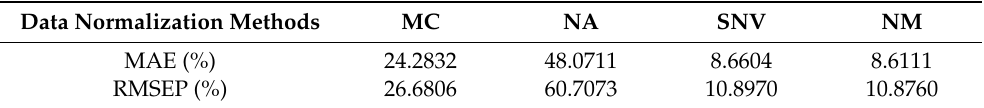
Table 3. MAE and RMSEP of the test set obtained using the PLSR model under the four data normalization methods.